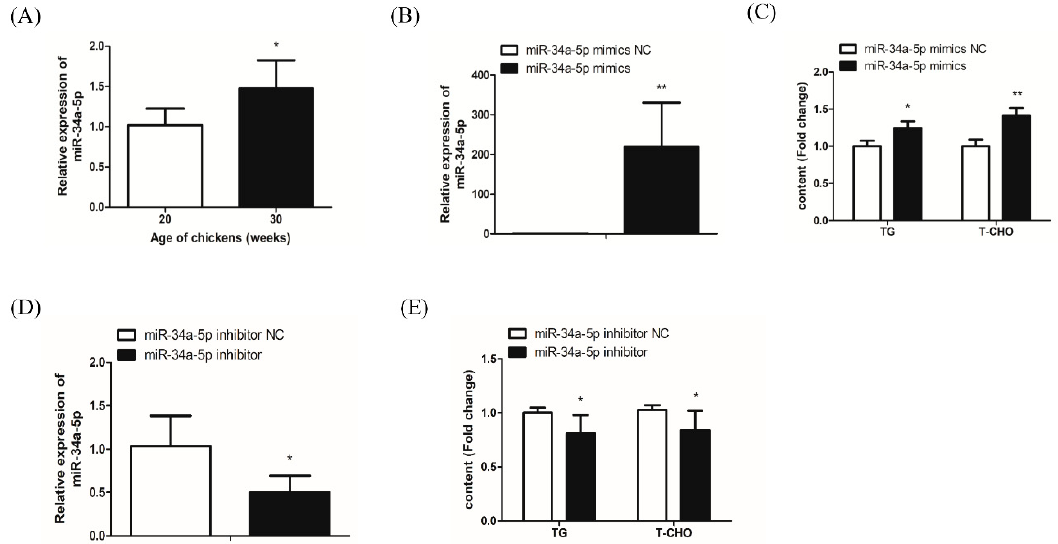
Figure 2. miR-34a-5p positively regulates hepatocyte TG and T-CHO levels in laying hens. ( A ) The relative expression of miR-34a-5p in the livers of pre-laying (20 weeks old) and peak-laying (30 weeks old) hens ( n = 6); ( B ) detection of miR-34a-5p overexpression 24 h after transfecting miR-34a-5p mimics; ( C ) effects of overexpressed miR-34a-5p on intracellular TG and T-CHO levels in LMH cells; ( D ) detection of miR-34a-5p inhibition 24 h after transfecting miR-34a-5p inhibitor; ( E ) effects of miR-34a-5p inhibition on intracellular TG and T-CHO levels in LMH cells. All data are presented as mean ± SD ( n = 4 to 6). * p < 0.05, ** p < 0.01.